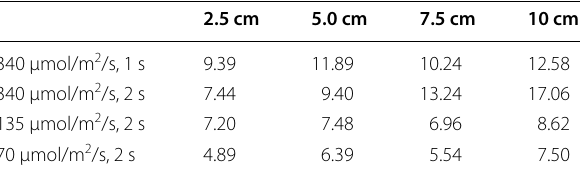
Table 2 Average productivity of different culture condi- tions (g/m 2